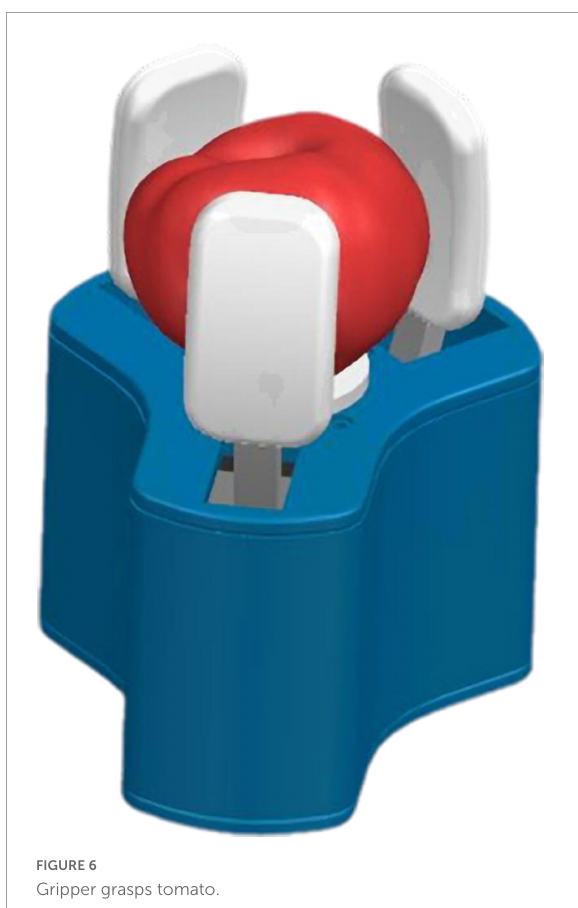
FIGURE6 Gripper grasps